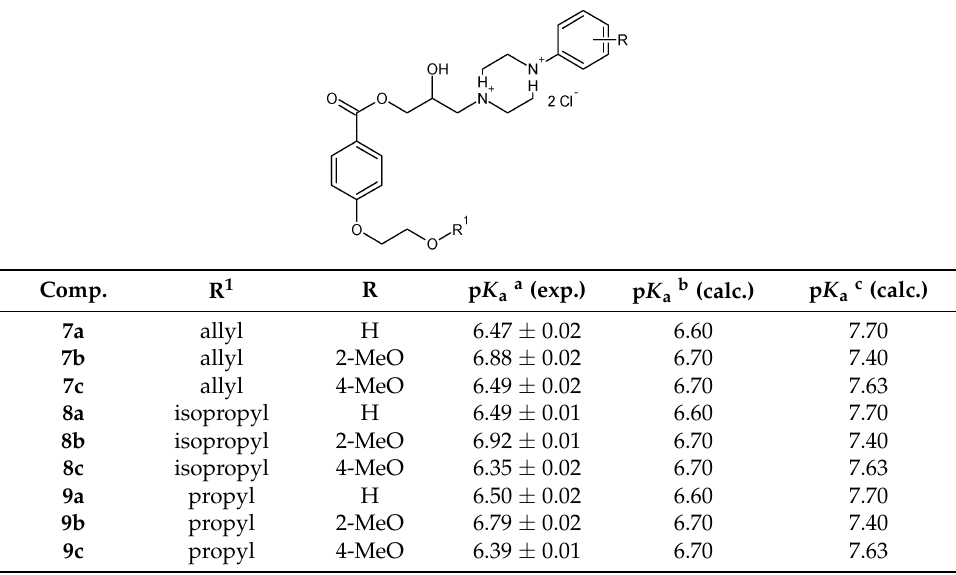
Table 1. Experimentally determined p K a in comparison with calculated values of final compounds.